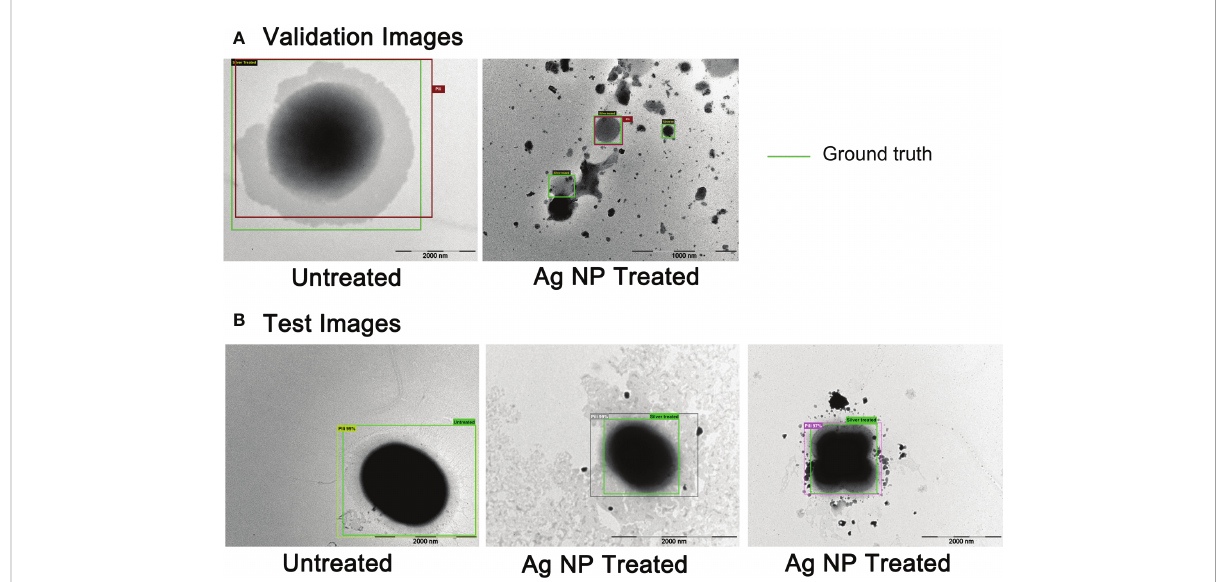
FIGURE 7 The AI detection of untreated and treated E faecium 1449 in TEM images based on R-CNNs technique. (A) TEM images for validation. (B) TEM images for testing. The ground truth boxes were in green color, while boxes automatically identi fi ed by AI were in different colors other than